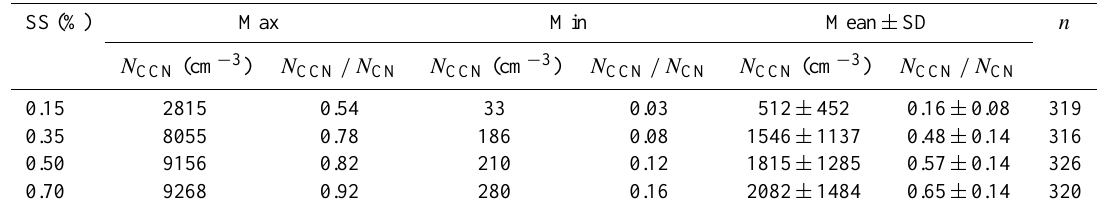
Table 1. Statistics of the bulk N CCN (cm − 3 ) at four SS (%) showing the minimum, maximum, mean number concentration, the N CCN /N CN ratio, and standard deviation (SD). The last column shows the number of data sets ( n) in this campaign. SS (%) Max Min Mean ± SD